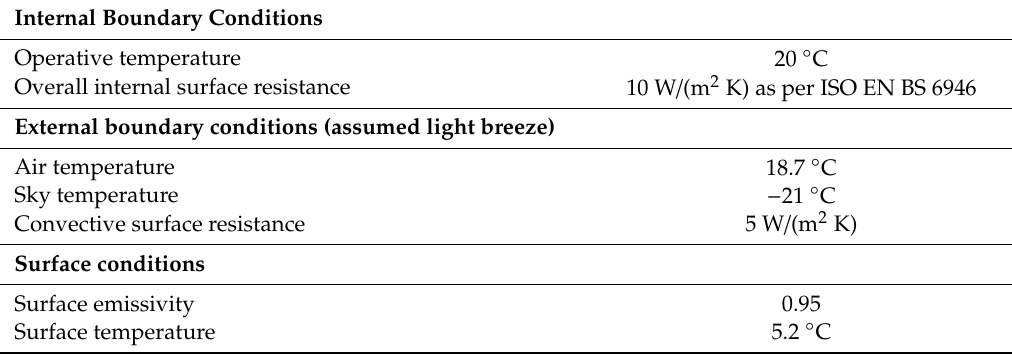
Table 4. Parameters used in the evaluation of the surface temperature, performed by ARUP